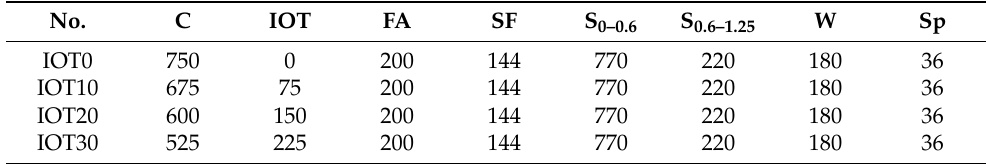
Table 2. Mix proportion of designed UHPC (kg/m 3 ).